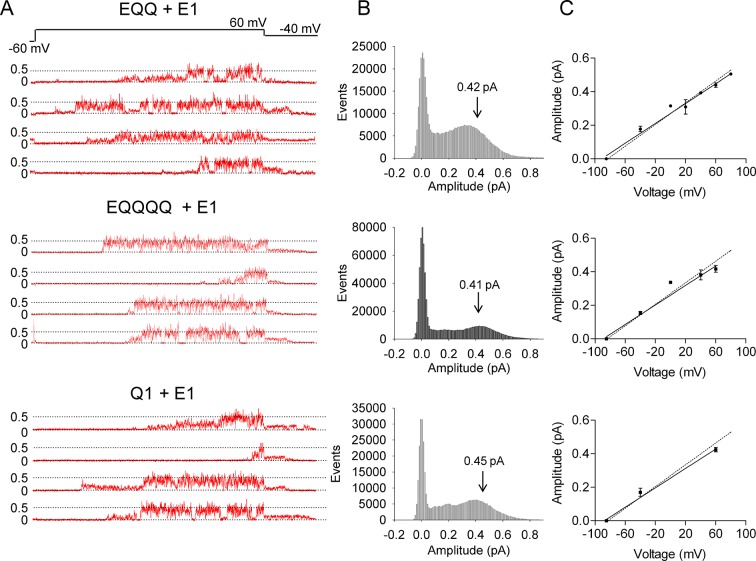
Co-expression of additional KCNE1 subunits restores wild type IKs single channel behavior to EQQ and EQQQQ.(A) Representative traces of single channel recordings from cells expressing EQQ + KCNE1-GFP (top), EQQQQ + KCNE1-GFP (middle) or KCNQ1 + KCNE1-GFP (bottom). (B) All-points amplitude histograms of only the active single channel sweeps as described in Figure 2. Arrows indicate the peak conductance as determined by Gaussian fits using Clampfit. (C) The peak open amplitudes for several voltages were plotted as in Figure 2.